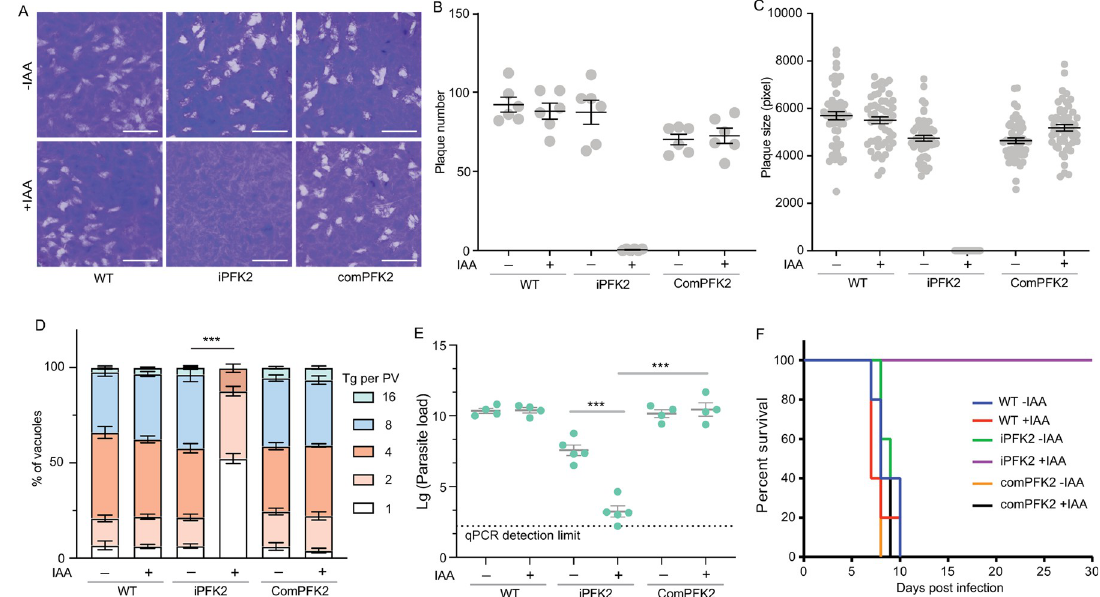
Fig 4. PFK2 is essential for tachyzoite growth. A : Plaque assay of the indicated strains in the presence or absence of IAA. B-C : Numbers and sizes of plaques from A. The experiments were repeated twice independently, each with three replicates. D : Intracellular replication of parasites in HFF cells. The means ± SEM of three independent experiments. ��� p � 0.001, two-way ANOVA. E : Parasite burden in peritoneal fluids of mice 5 days post infection, n = 4 or 5. ��� p < 0.001, unpaired student’s t-test. F : Survival of mice treated with or without IAA after being infected with indicated